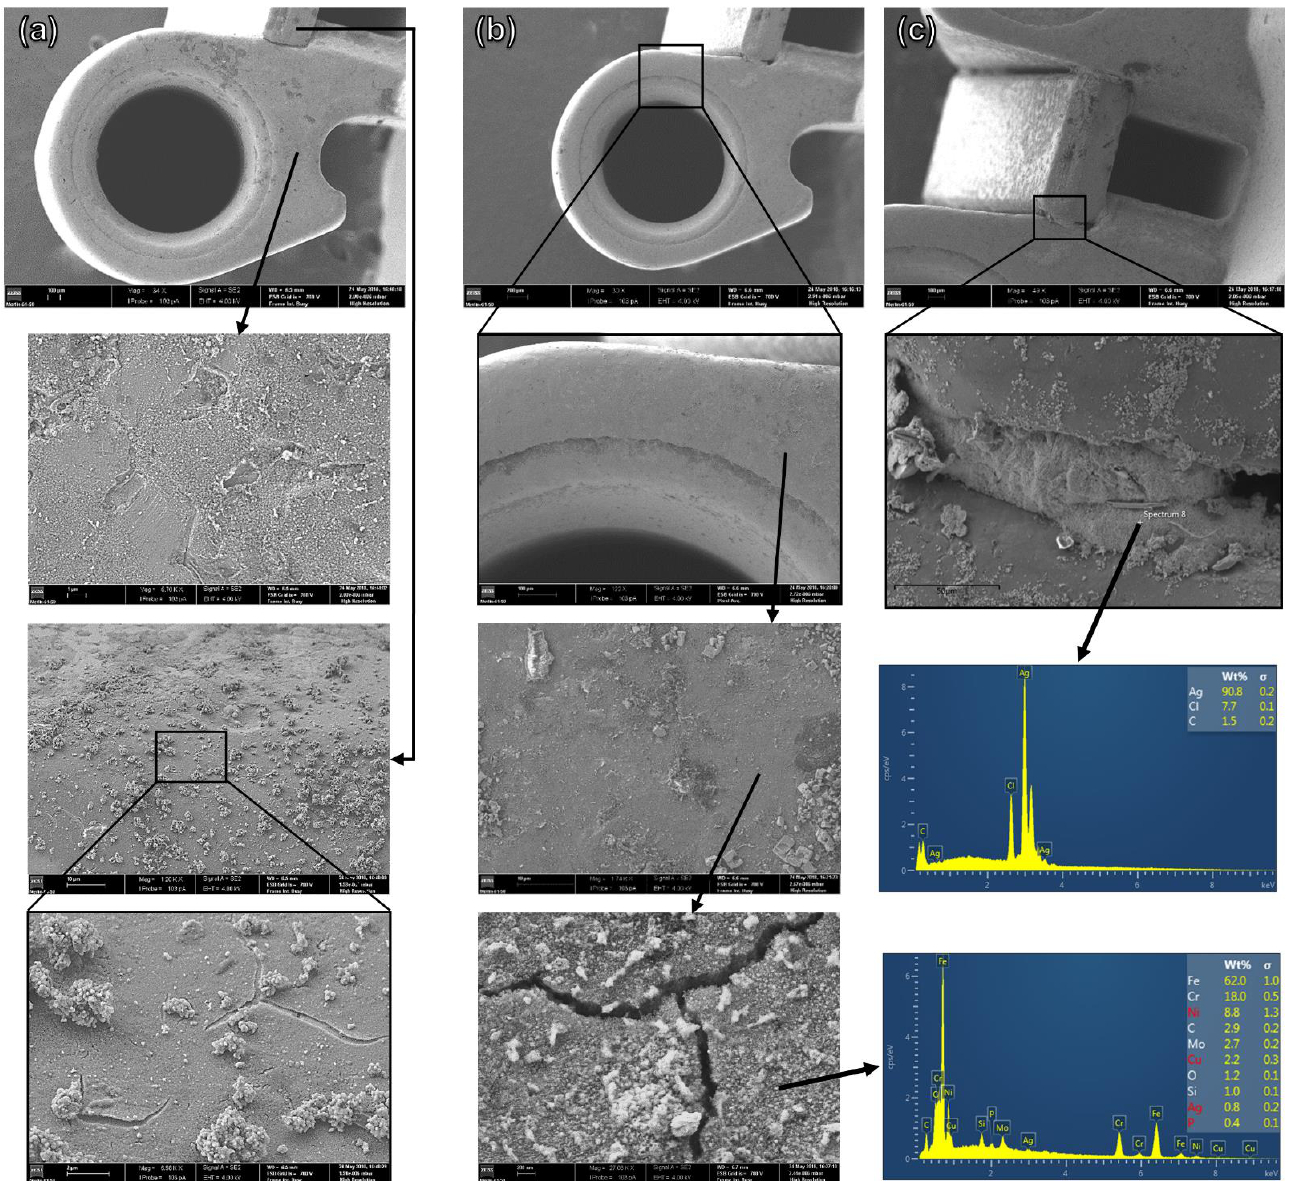
Figure 5. SEM surface micrographs and EDS analysis of the dental tube attached to the bands after the corrosion test at ( a ) pH = 6.8, and ( b , c ) pH = 2.3.